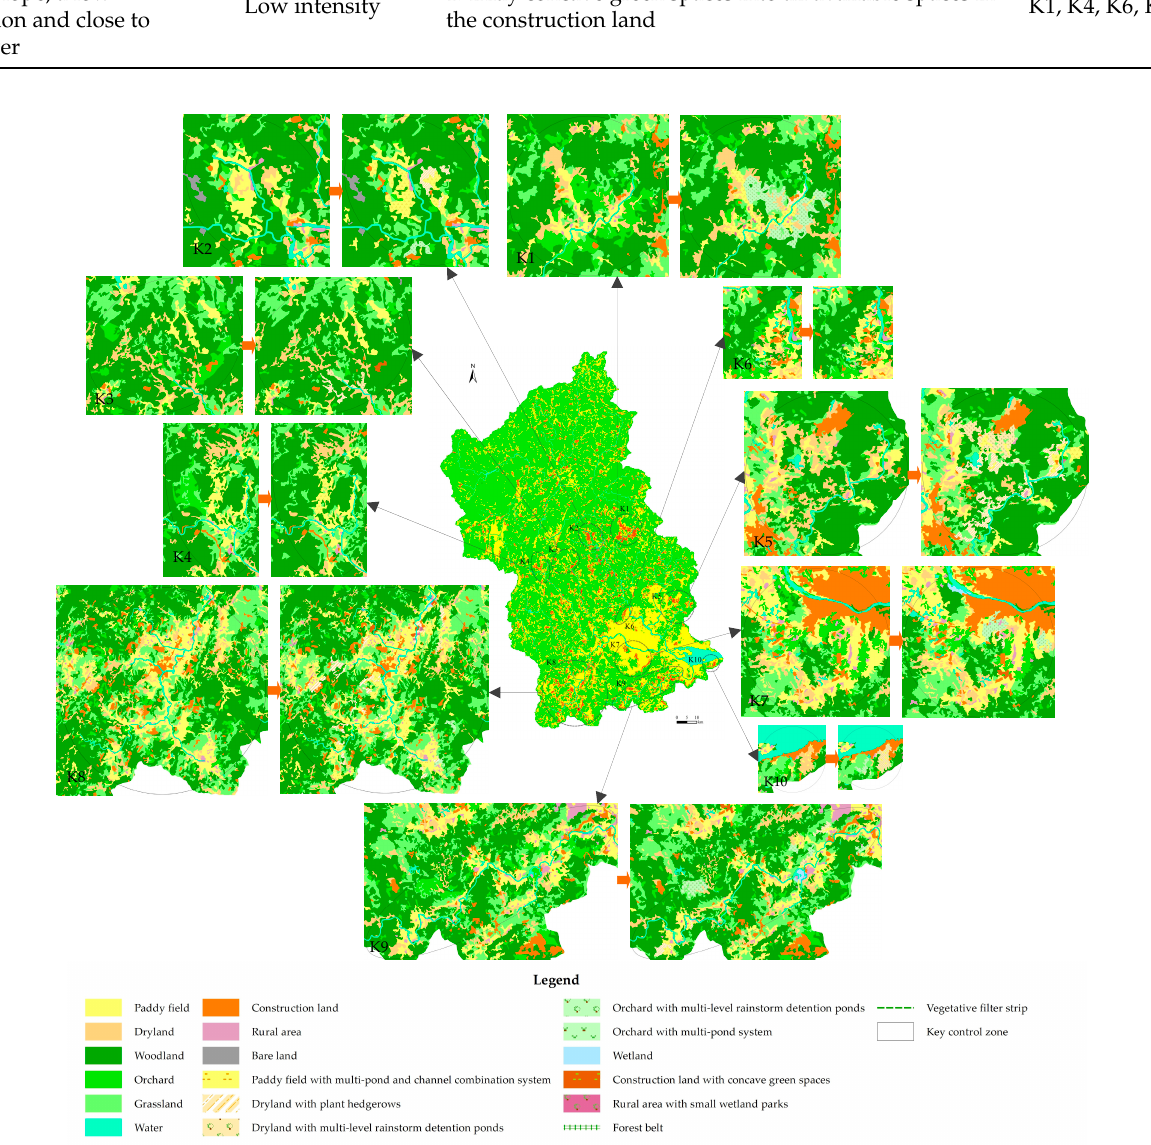
Figure 6. The medium- and low-intensity regulation strategies for the 10 key control zones in the Jiulong River